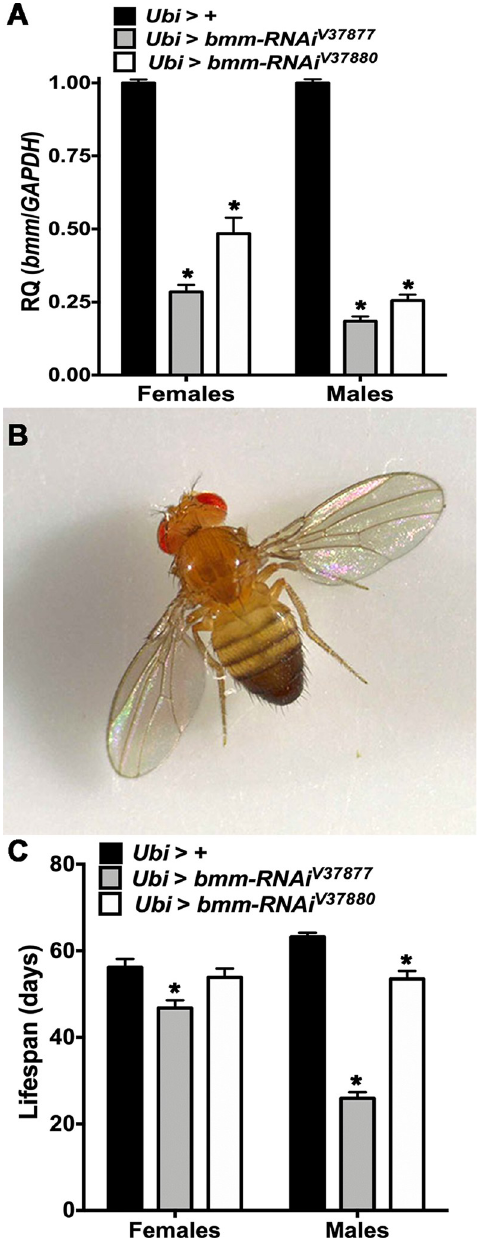
Fig 1. RT-qPCR and lifespan of Ubi > bmm-RNAi flies. Offspring of Ubi-Gal4 mated with GD control ( Ubi > +) or UAS-bmm-RNAi flies ( Ubi > bmm-RNAi V37877 and Ubi > bmm-RNAi V37880 ) were used for the assays. Asterisks indicate significant differences at p < 0.05 compared with the appropriate female or male control, following Tukey’s correction for multiple tests. (a) RT-qPCR (n = 9 for females and males of each genotype), relative quantification (RQ) was done using the 2 - ΔΔ Ct method, and GAPDH was used as an internal standard. (b) Spread wings phenotype in males of Ubi > bmm-RNAi V37877 (100%, n = 100). (c) Average lifespan for Ubi > + (n = 132 for females and 118 for males), Ubi > bmm-RNAi V37877 (n = 136 for females and 134 for males) and Ubi > bmm-RNAi V37880 (n = 137 for females and 132 for males). Error bars are standard errors of the mean (SEM). ANOVA tests are reported in S1 Table.